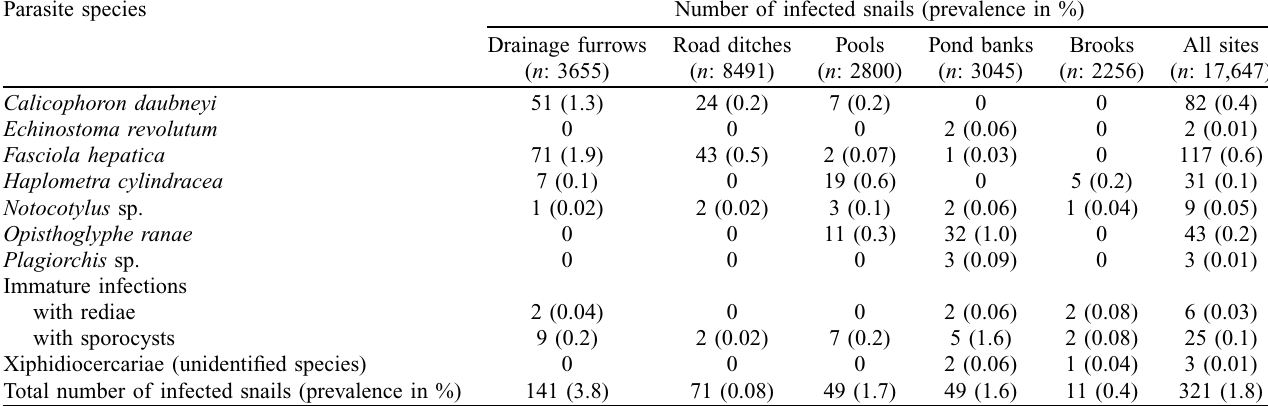
Table 2. Number of Lymnaea glabra infected by each digenean species and prevalence of natural infection in five types of habitats located in the southern part of the Brenne Regional Natural Park, department of Indre, central France. n , total number of adult snails collected during the 2 years of